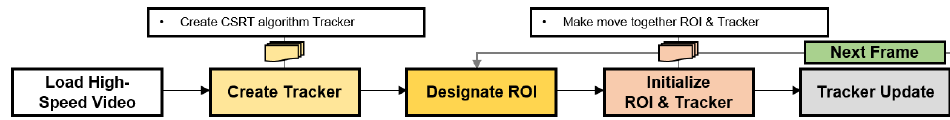
Figure 5. The schematic of the algorithm for tracking an individual bubble over